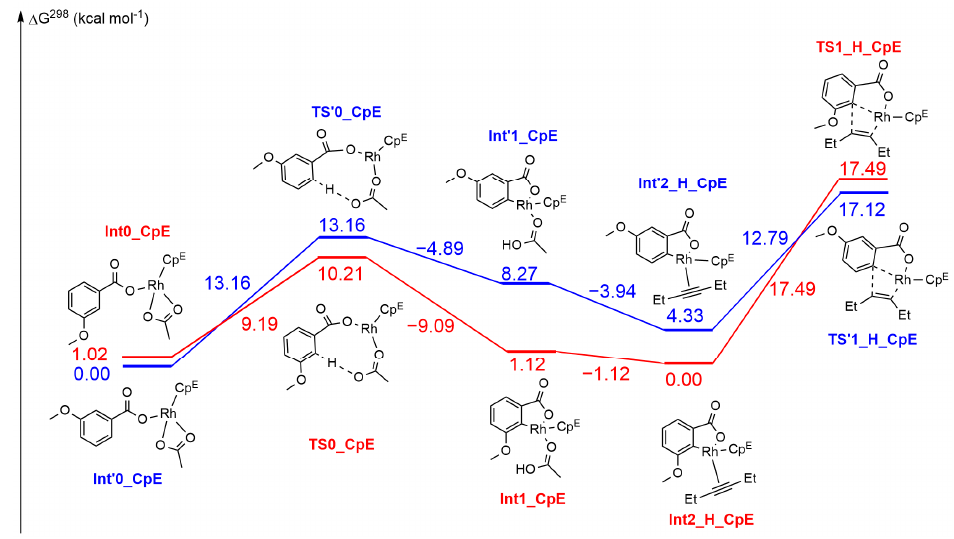
Figure 6. Energy profiles of C-H activation and alkyne insertion steps for the annulation of 1a with diethylacetylene catalyzed by [Cp E RhCl 2 ] 2 . The calculated Gibbs free energies are given relative to the Int’0_CpE intermediate at the M06L(D3)/LANL2DZ level with CPCM correction for methanol solvation (in kcal ⋅ mol − 1 , at 298 K).